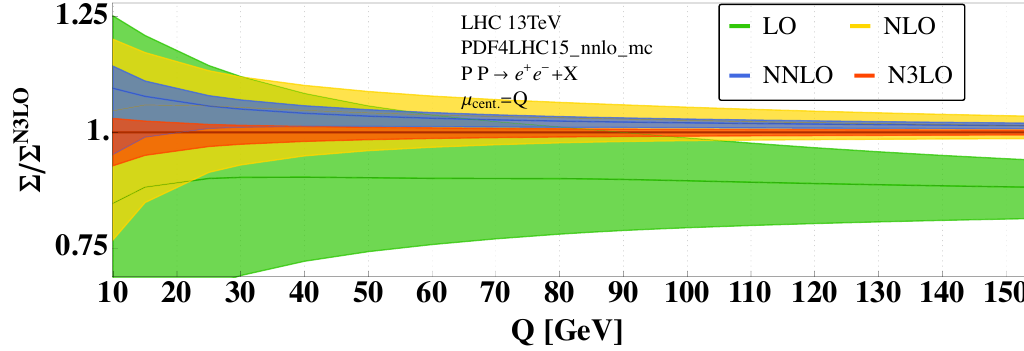
Figure 5. The K-factors Σ N k LO / Σ N 3 LO as a function of invariant masses 10 GeV ≤ Q ≤ 150 GeV for k ≤ 3 . The bands are obtained by varying the perturbative scales by a factor of two around the central µ cent. = Q .